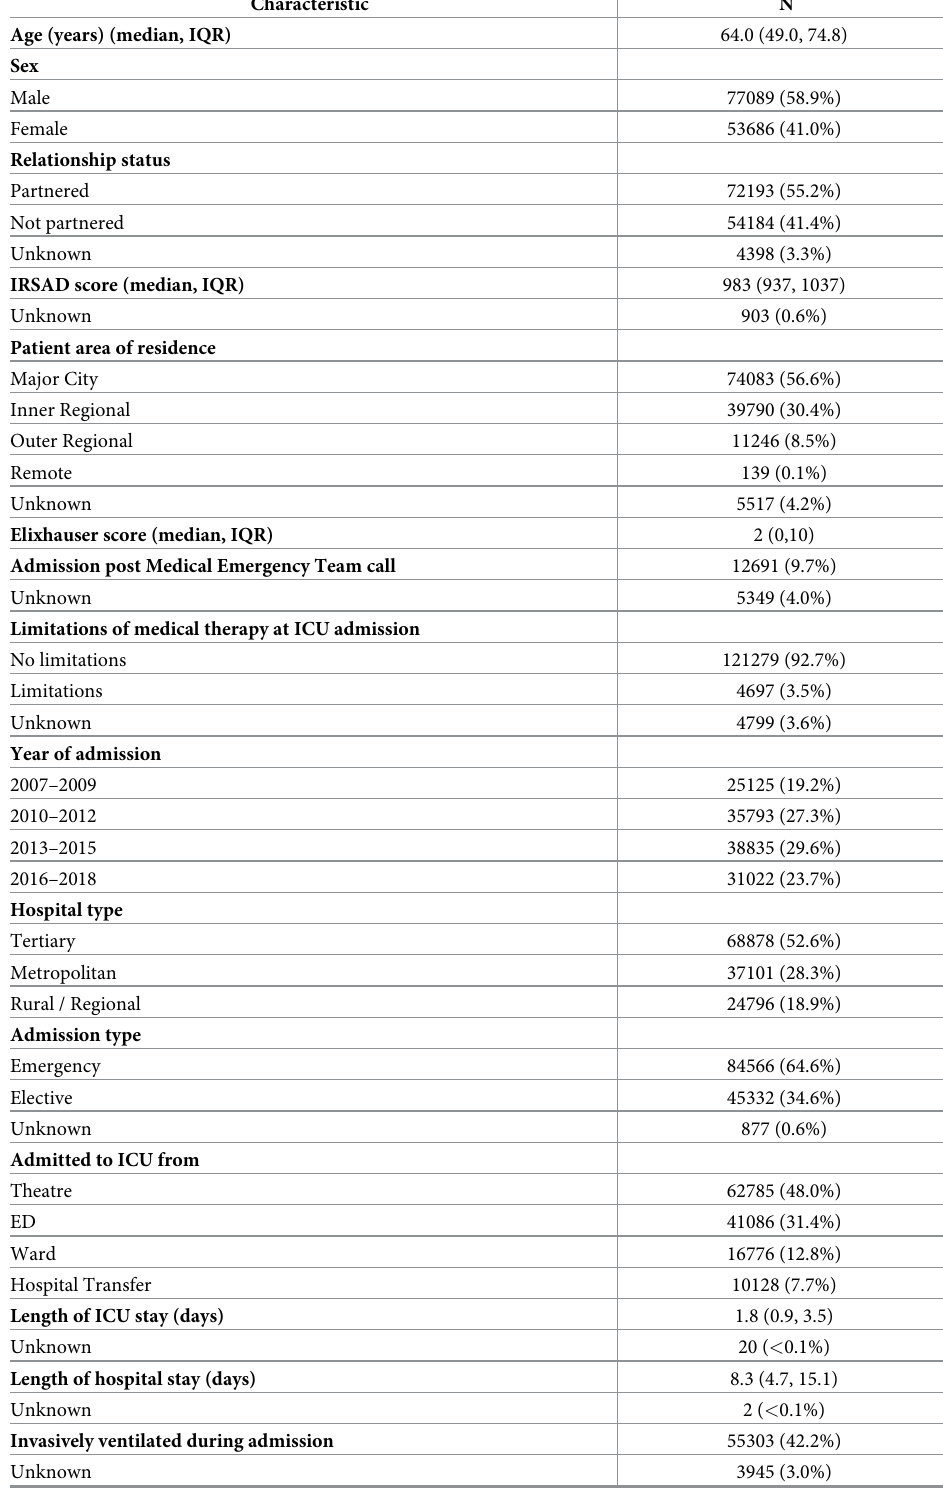
Table 1. Characteristics of the cohort (n =